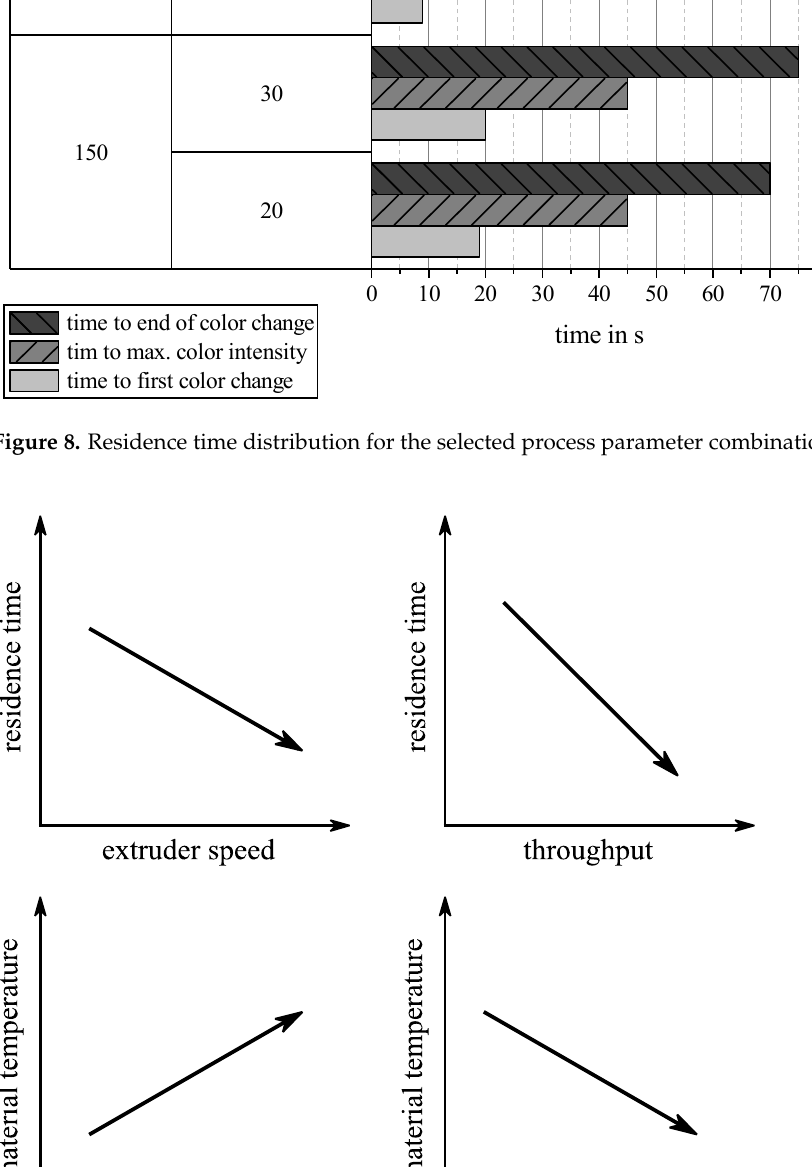
Figure 8. Residence time distribution for the selected process parameter combinations.